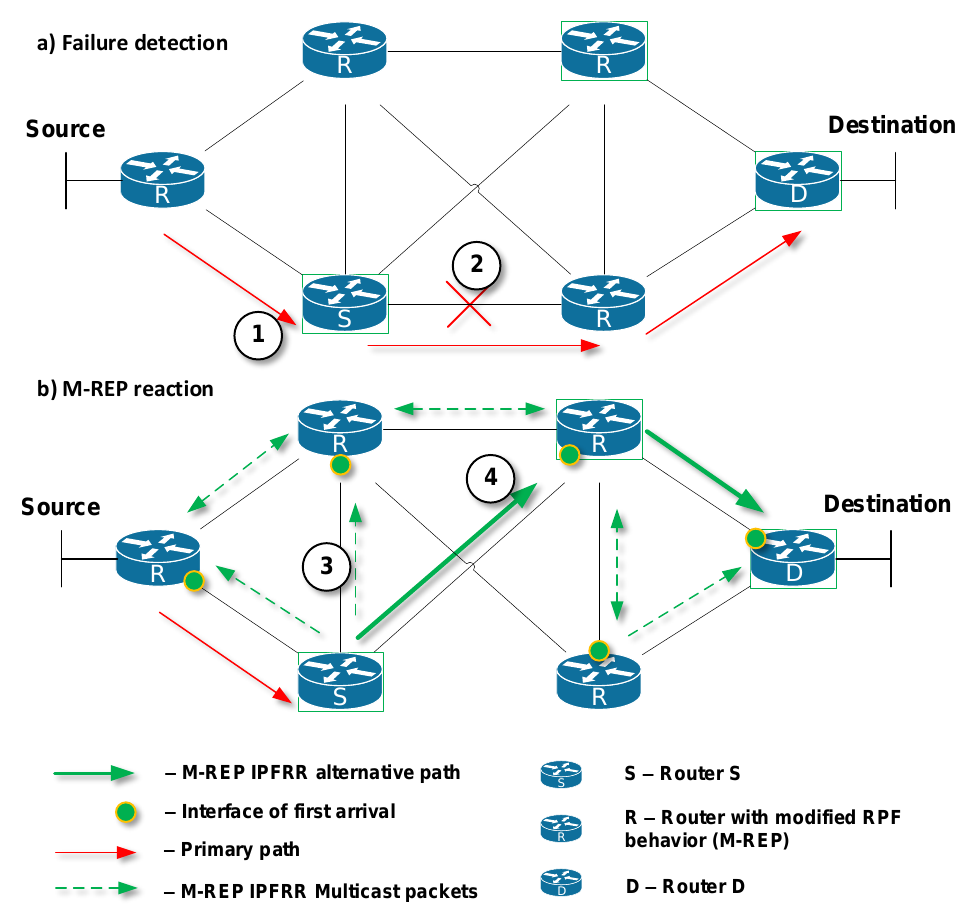
Figure 2. Principle of the M-REP mechanism